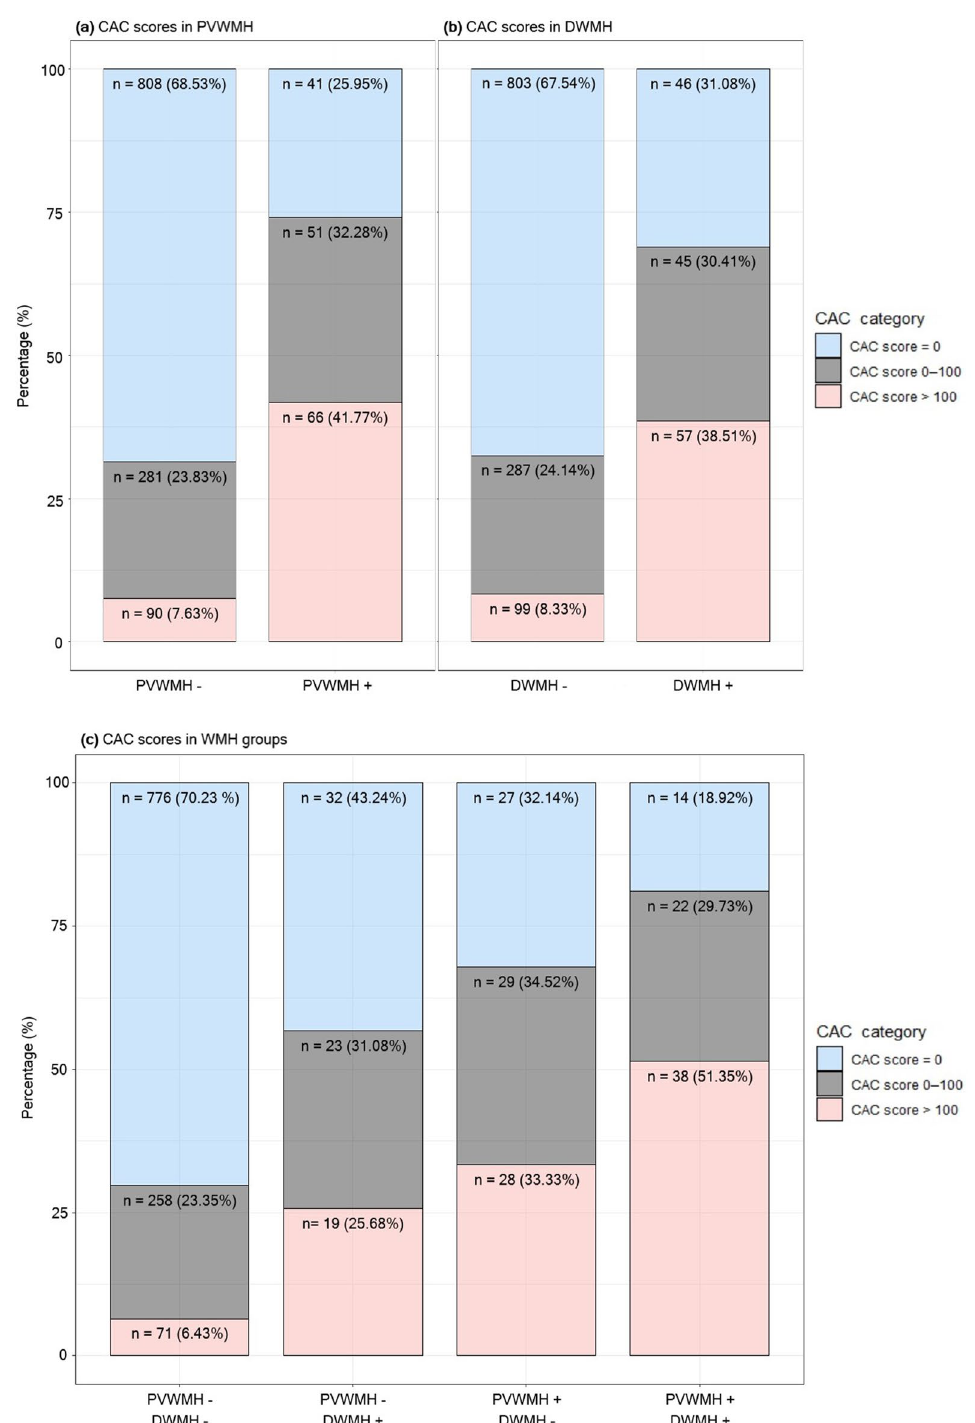
Figure 2. Percentages of CAC score categories according to the presence of PVMWH (a) , DWMH (b) and PVWMH or DWMH (c) . CAC Coronary artery calcium, WMH White matter hyperintensity, PVWMH Periventricular white matter hyperintensity, DWMH Deep white matter